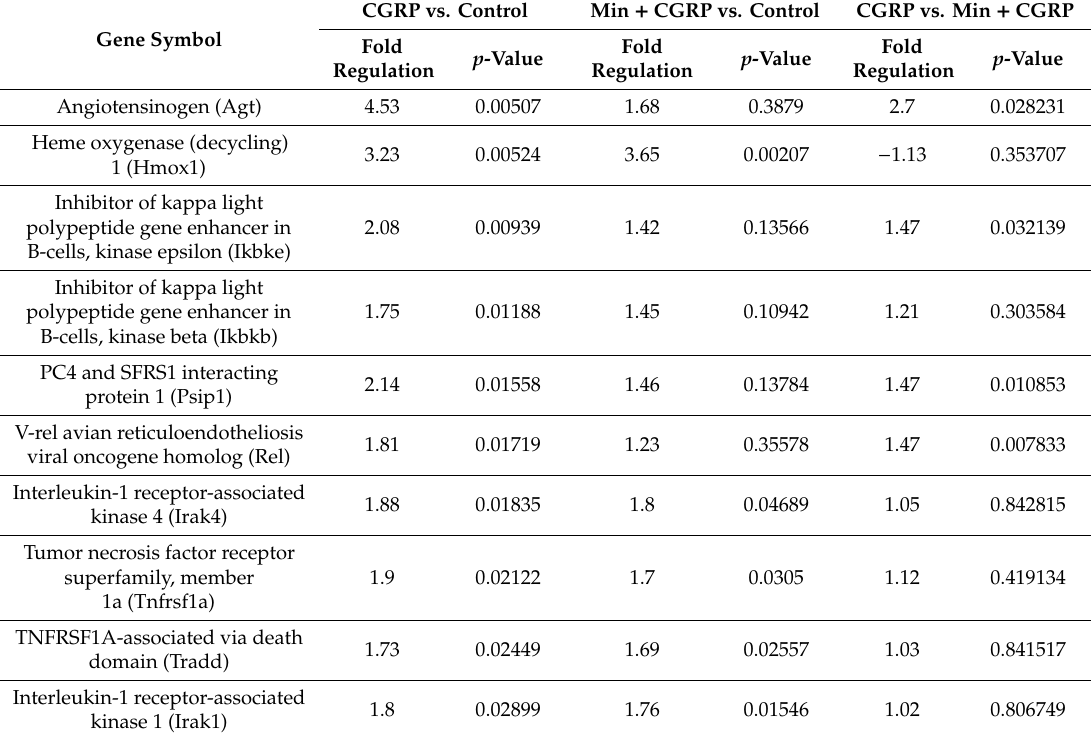
Table 1. Gene regulation in the glial cells of Trigeminal ganglion of NF- κ B signaling pathway using RT PCR array when glial cells were stimulated with CGRP compared to no treatment control group, when glial cells were treated with Minocycline for 30 min followed by CGRP stimulation (Min + CGRP) compared to control and CGRP and Min + CGRP group. (Data is arranged in the increasing order of p -value of CGRP vs. control group). CGRP vs. Control Min + CGRP vs. Control CGRP vs. Min + Gene Symbol